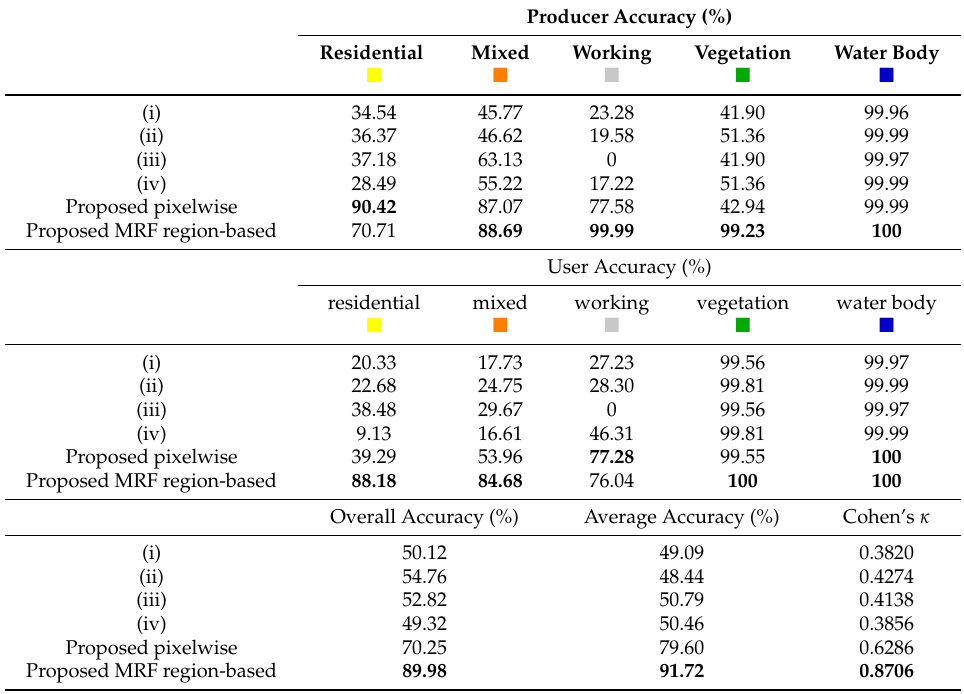
Table 2. Producer, user, overall, average accuracies and Cohen’s κ of the proposed methods and of the compared approaches: (i) classification of only the spectral channels; (ii) soft-majority voting applied to the pixelwise posteriors estimated from only the spectral channels; (iii) classification in the stacked feature space of spectral channels, NDVI, and texture features; and (iv) soft-majority voting applied to the pixelwise posteriors estimated in the stacked feature